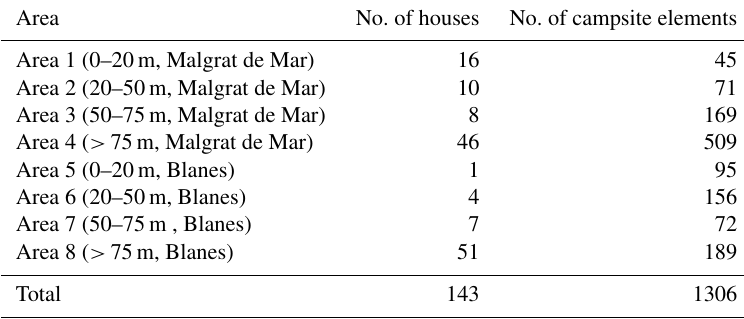
Table 2. Distribution of receptors at the Tordera Delta study site.